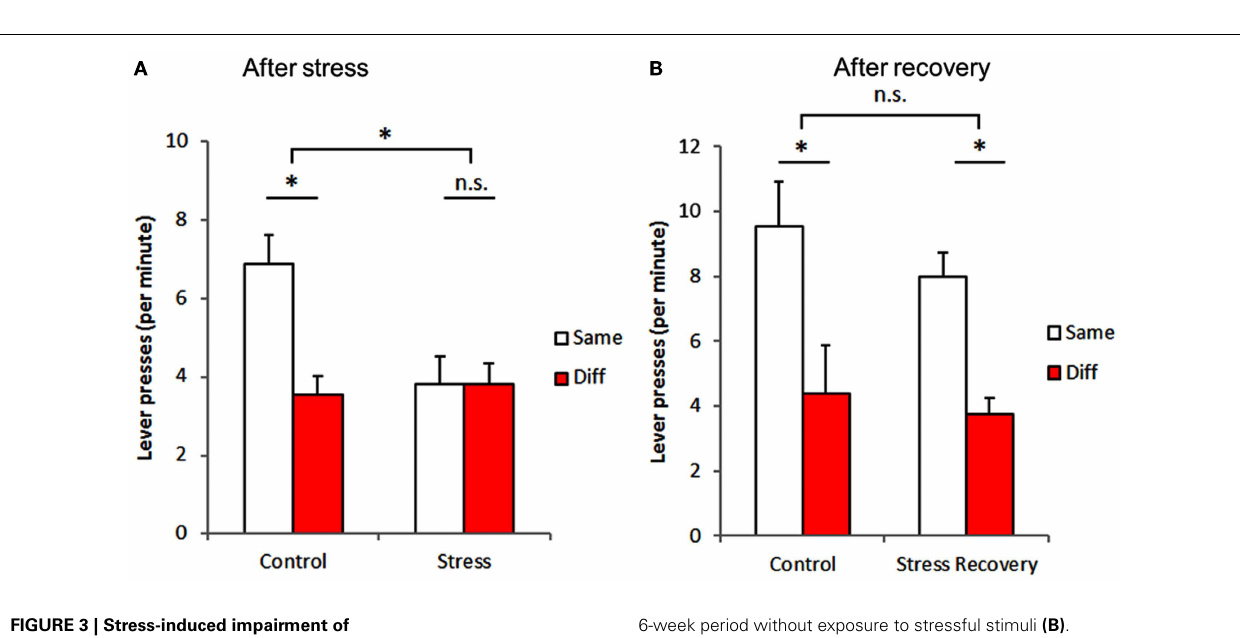
6-week period without exposure to stressful stimuli (B) . Same – conditioned stimulus (sound) predicted the same outcome as the lever pressed; Diff – conditioned stimulus (sound) predicted a different outcome as the lever pressed. * p <